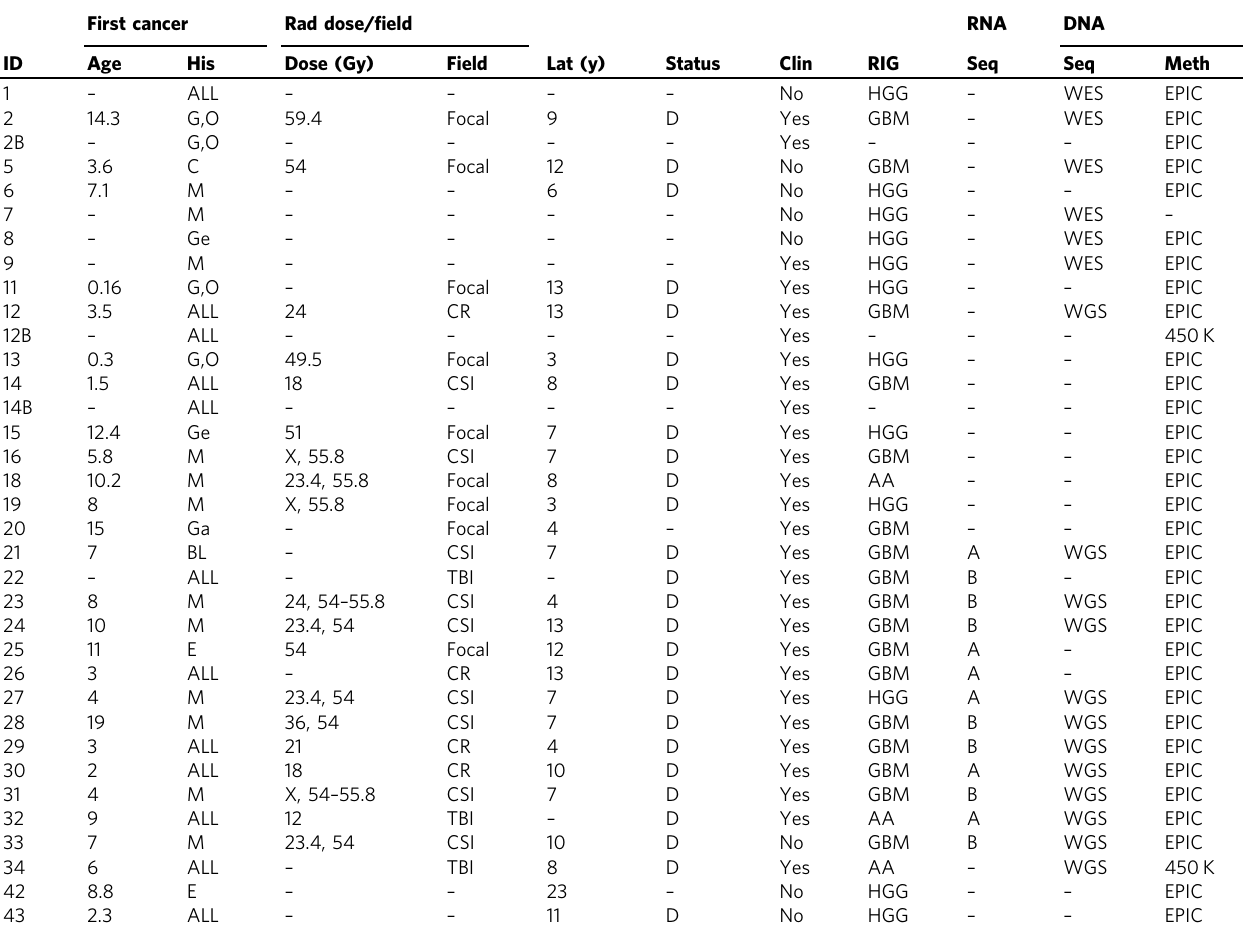
Table 1 Summary of RIG samples included in the